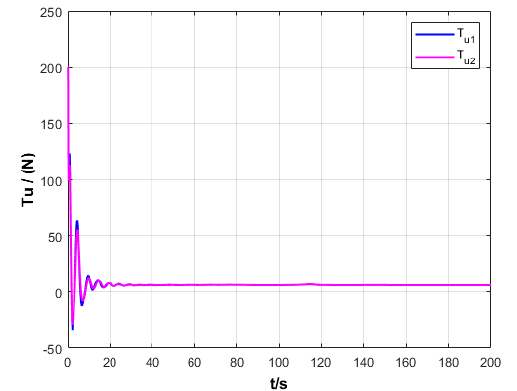
Figure 13. Forward thrust variation of USV under two strategies.